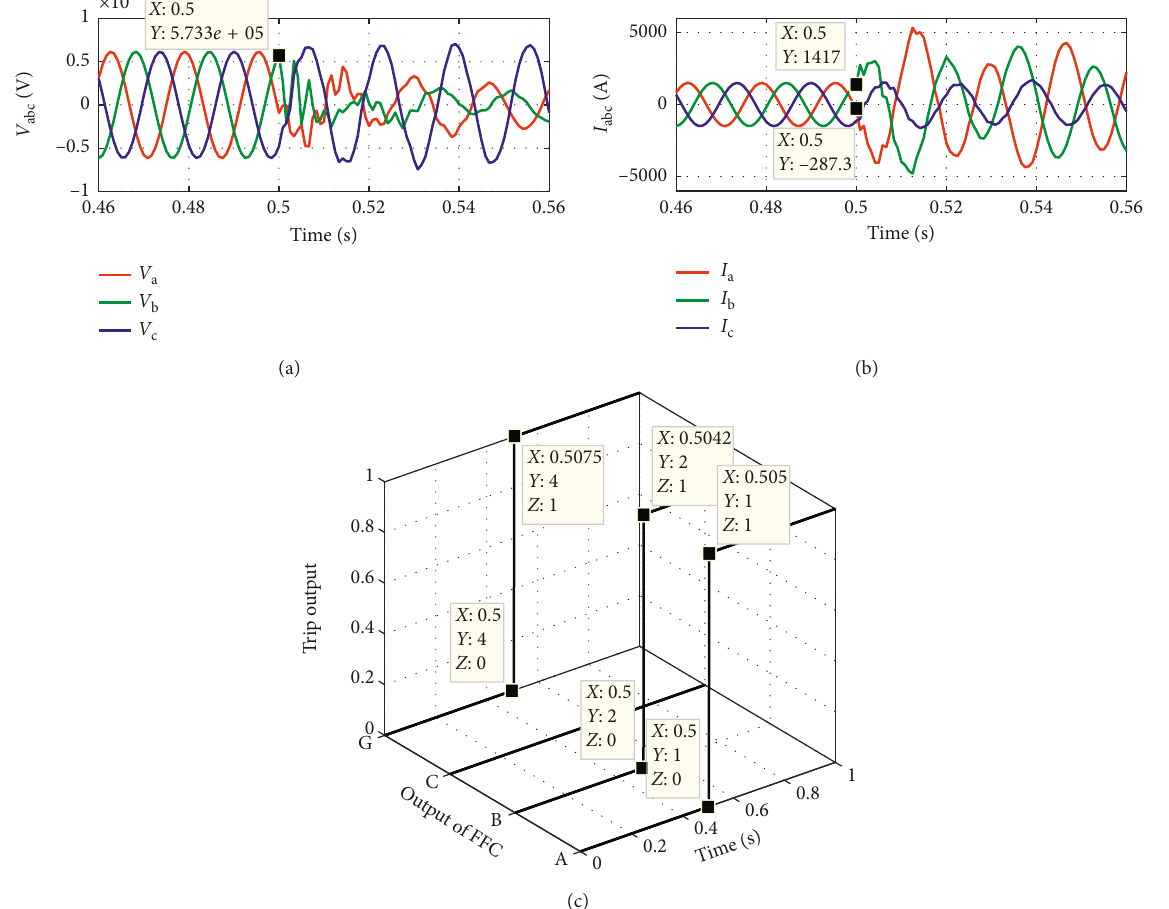
Figure 10: Performance during ABG fault under change in system frequency at 165km, FIA voltage waveform; (b) 3-phase current waveform; (c) output of Table 11: Simulation results for the heavy load interconnection (FIA Simulated system data Results obtained from the proposed CDFTF-based scheme Load